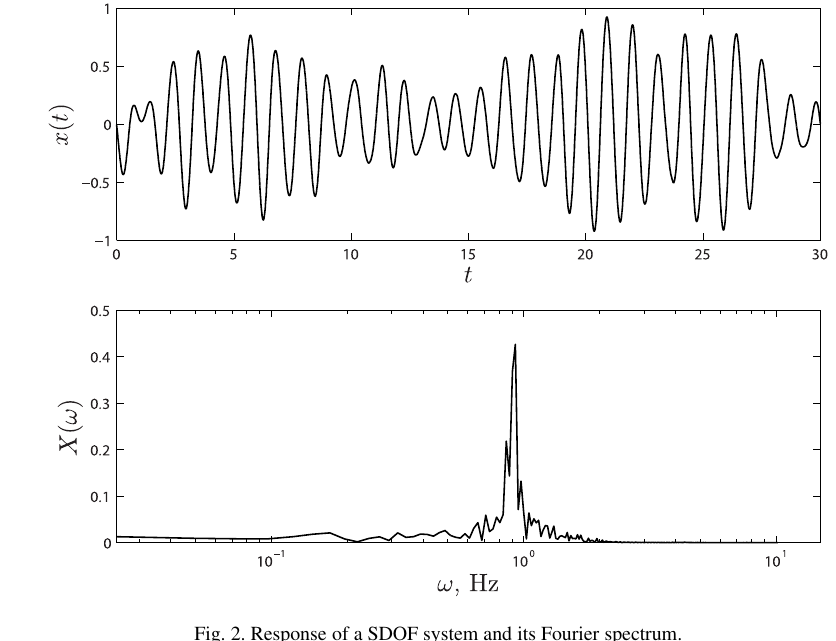
Fig. 2. Response of a SDOF system and its Fourier